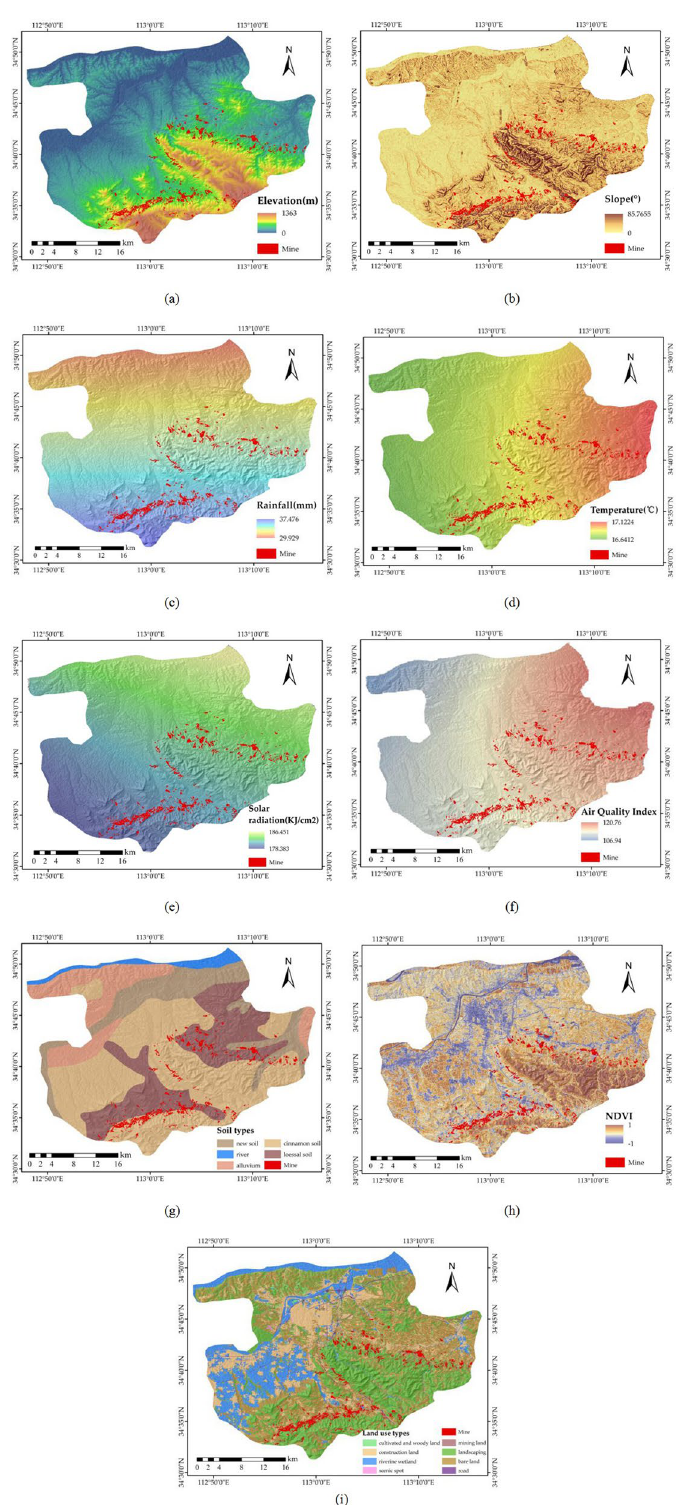
Figure 3. Socio-natural factors. ( a ) Elevation; ( b ) slope; ( c ) rainfall; ( d ) temperature; ( e ) solar radiation; ( f ) air quality index; ( g ) soil type; ( h ) NDVI; and ( i ) land use types. The Figure is created using ArcGIS ver.10.3 (https:// www. esri.